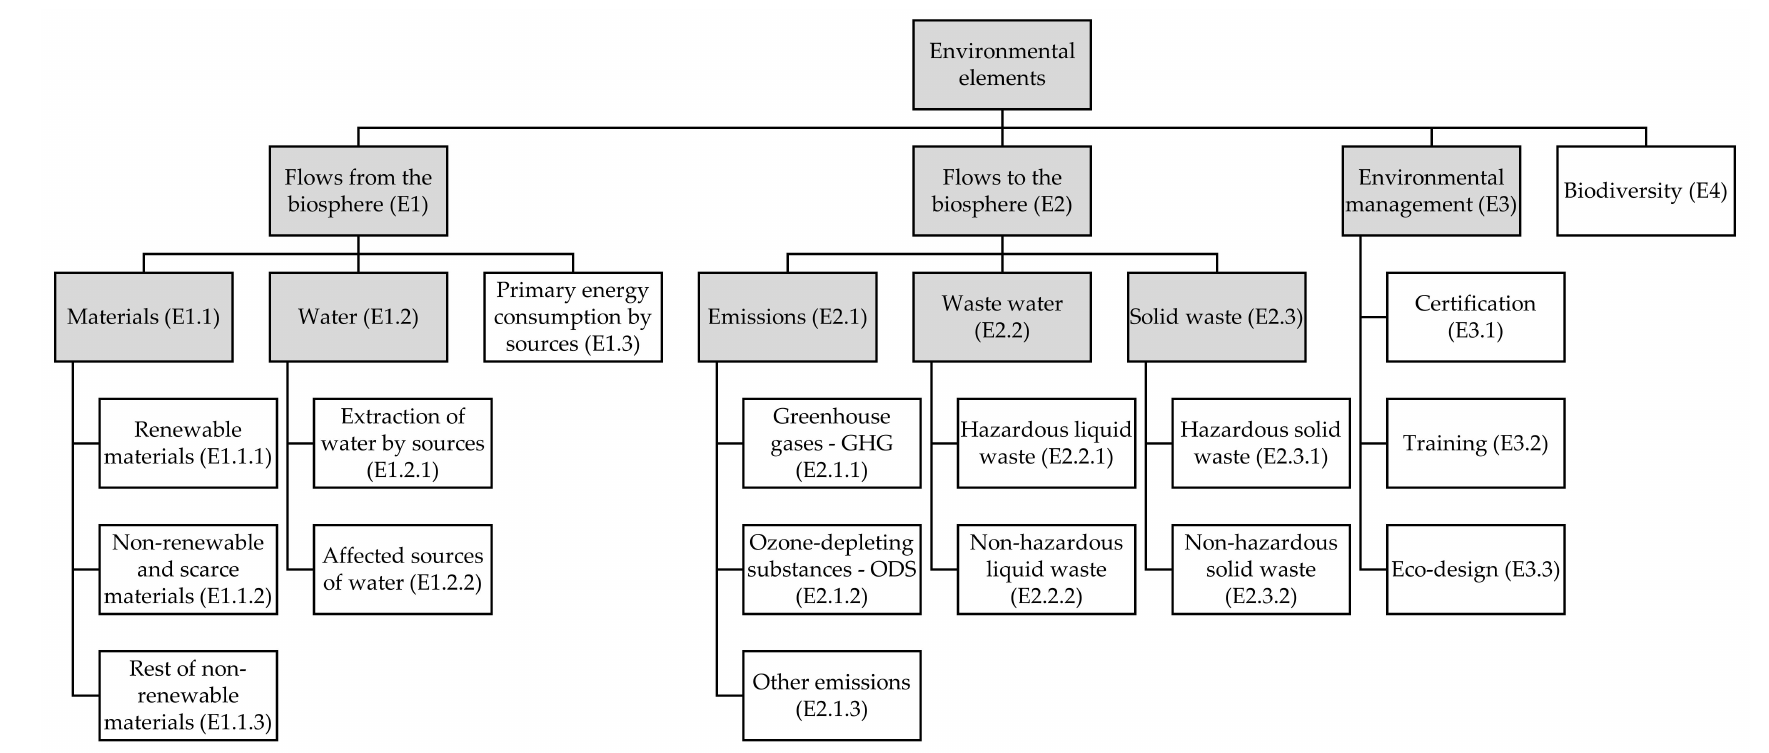
Figure 2. Hierarchy of the environmental elements for anticipation and reflexivity activities for any research line without initial environmental